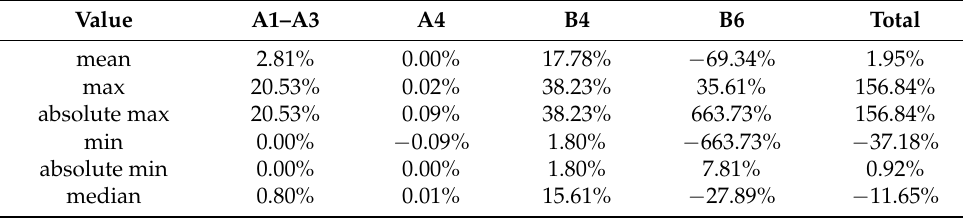
Table 4. Statistical analysis of the most affected impact